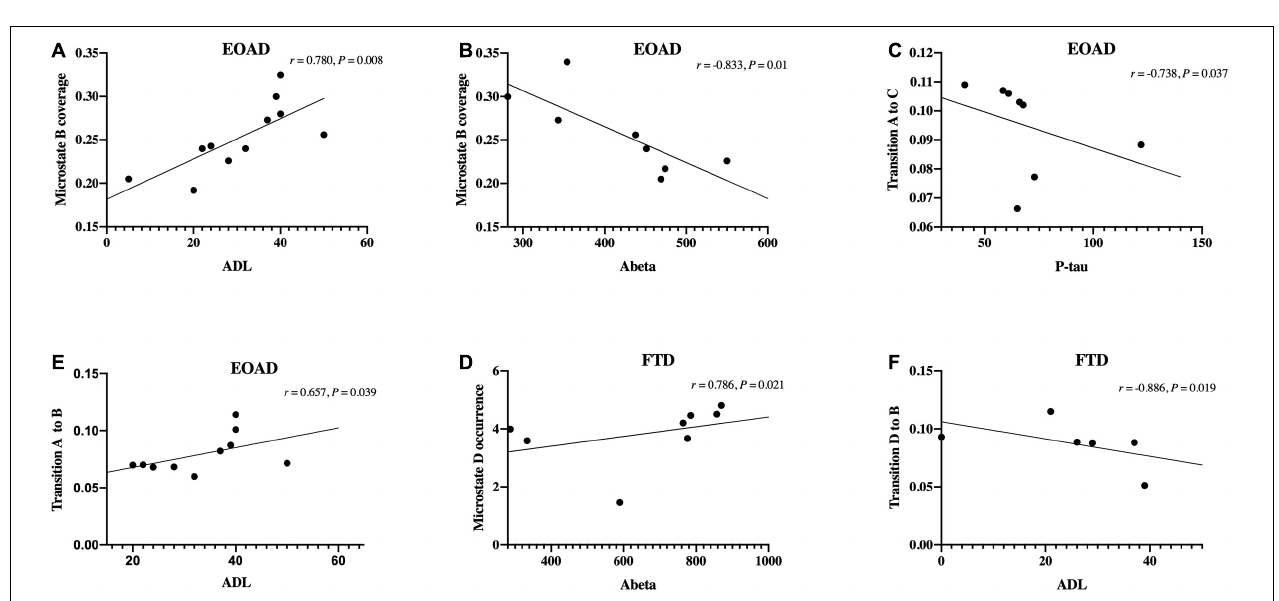
FIGURE 2 | Microstate characteristics. Group comparison of microstate duration (A) , occurrence (B) , and GFP peaks per second (C) . p -values result from pairwise post hoc tests following univariate ANOVAs. ∗ p < 0.05. FTD, frontotemporal dementia; EOAD, early-onset Alzheimer’s disease; HC, healthy controls; GFP, global field